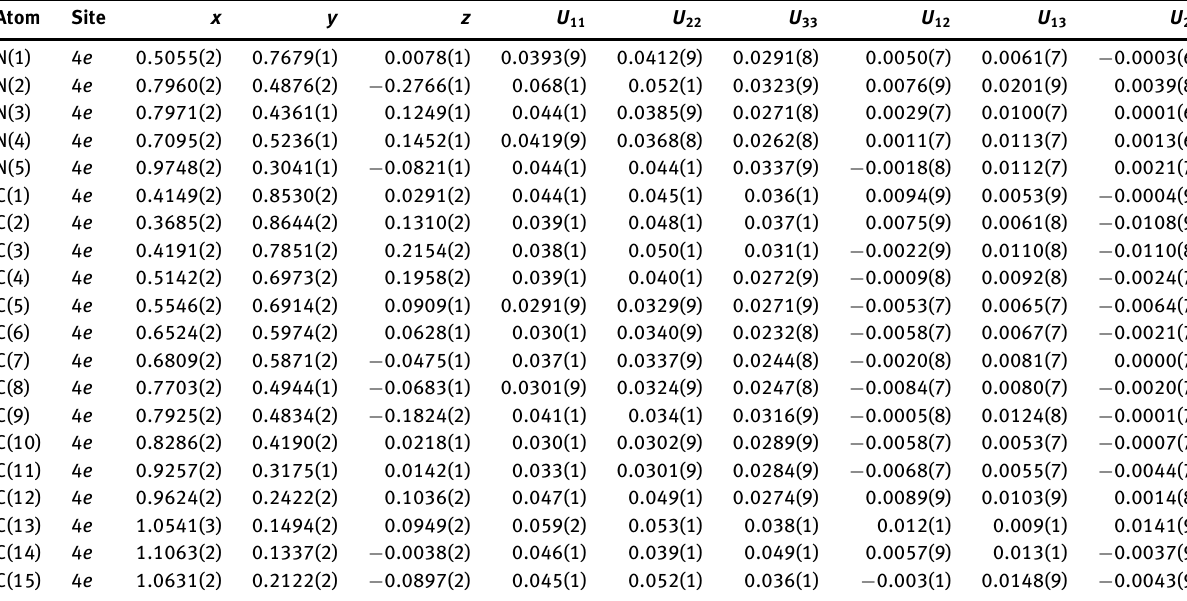
Table 3: Fractional atomic coordinate and displacement parameters (Å 2